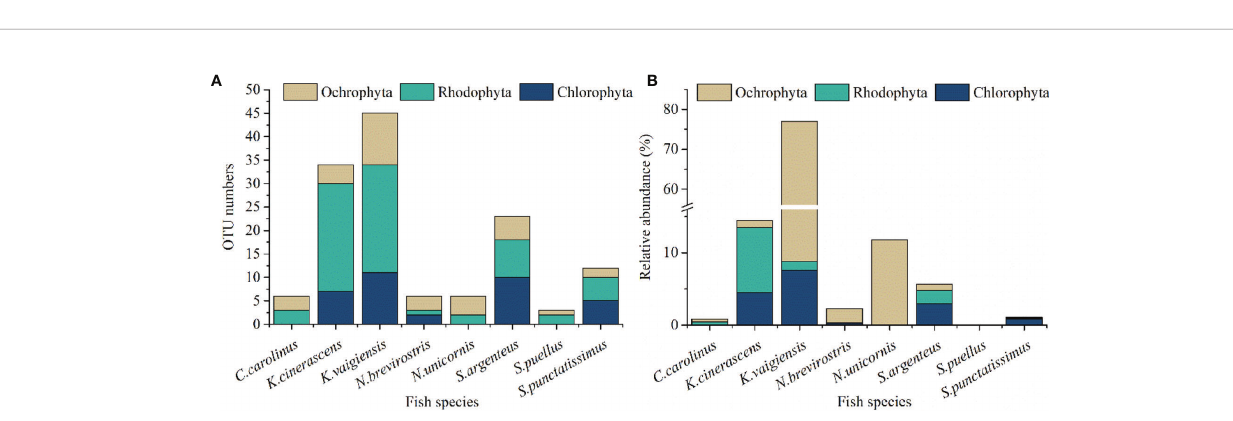
FIGURE 2 | Eukaryote sequences belonging to the phyla Chlorophyta, Ochrophyta and Rhodophyta obtained from intestinal contents of eight coral reef fi sh species which were collected from the Xisha Islands, China. (A) OTU numbers of taxonomic groups. (B) Relative abundance of taxonomic